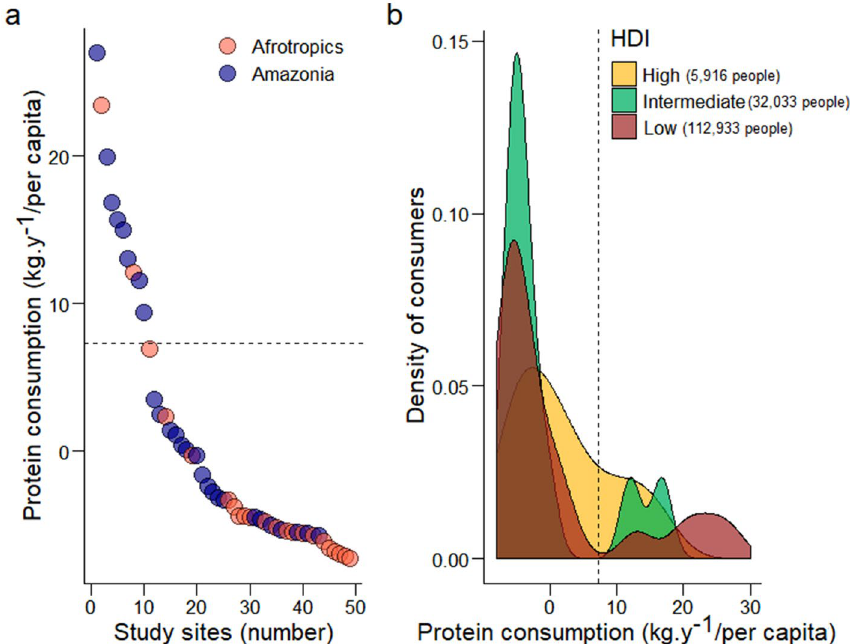
Figure 2. Distribution of mean annual per capita wild meat protein consumption rate in Amazonian and Afrotropical forest sites, ordered from the highest to the lowest consumption levels ( a ); and density distribution of consumers in relation to the Human Development Index (HDI) assigned to the smallest available subnational political unit in which study sites were located ( b ). Black dashed line represents the minimum annual per capita protein consumption of ~ 7.3 kg per person per year as recommended by FAO (2014) to prevent human malnutrition and/or under-nourishment.